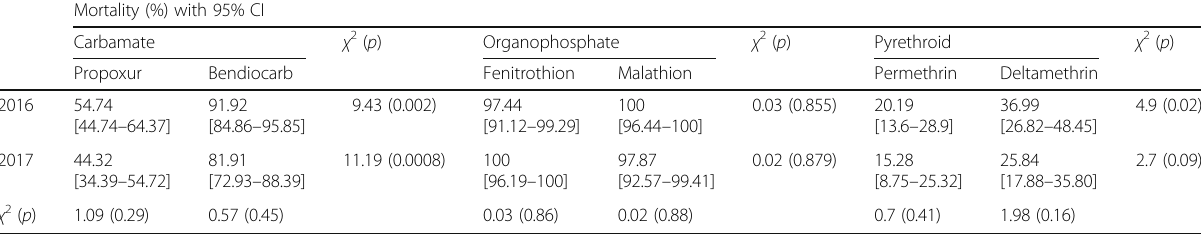
Numbers in brackets indicate the 95% CI; χ 2 was obtained by Pearson ’ s chi-squared